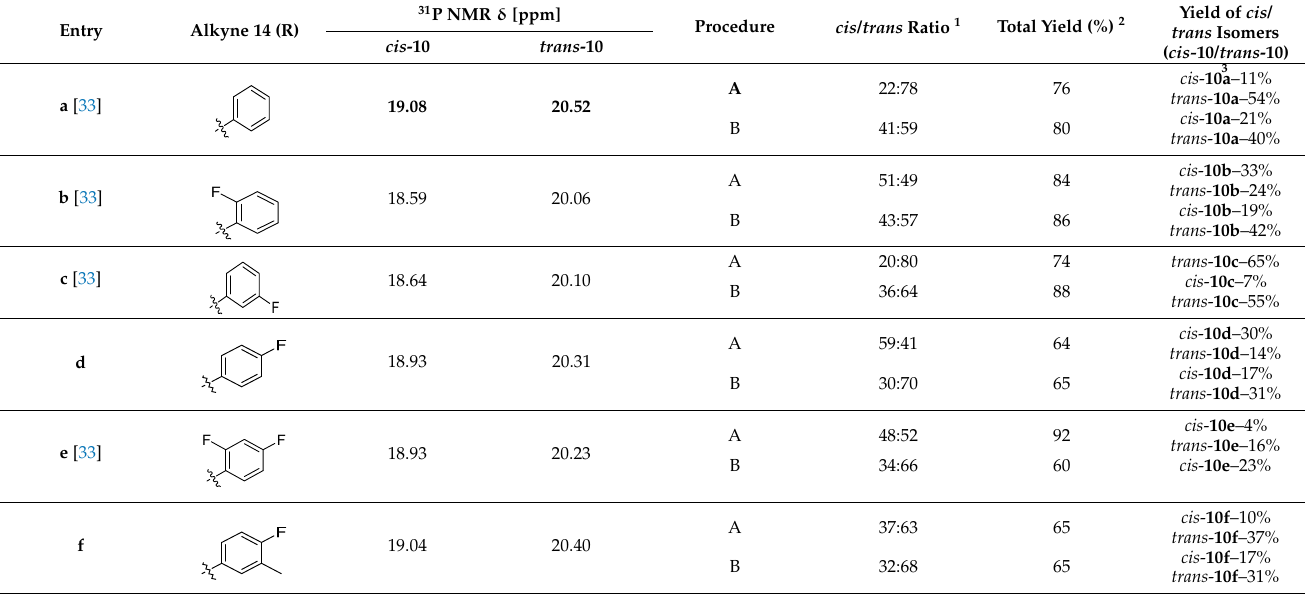
Table 2. Cycloaddtion of nitrone 13 with arylalkynes 14 .